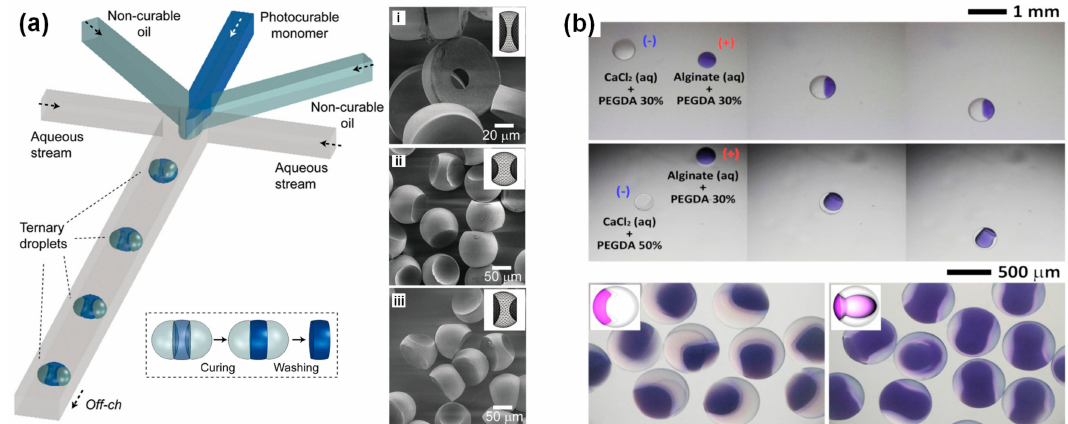
Figure 4. ( a ) On-chip synthesis of biconcave polymer microparticles with ternary components. Additionally, SEM images of biconcave polymer microparticles with di ff erent structures, which were produced from droplets by changing the flow-rate ratios of the droplet phases. Reproduced with permission from [110]. Copyright John Wiley and Sons, 2015. ( b ) Fabrication of Janus microparticles with di ff erent shaped via electric-field-induced droplet dispensing into oil based on digital microfluidics. Reproduced with permission from [111]. Copyright Nature,